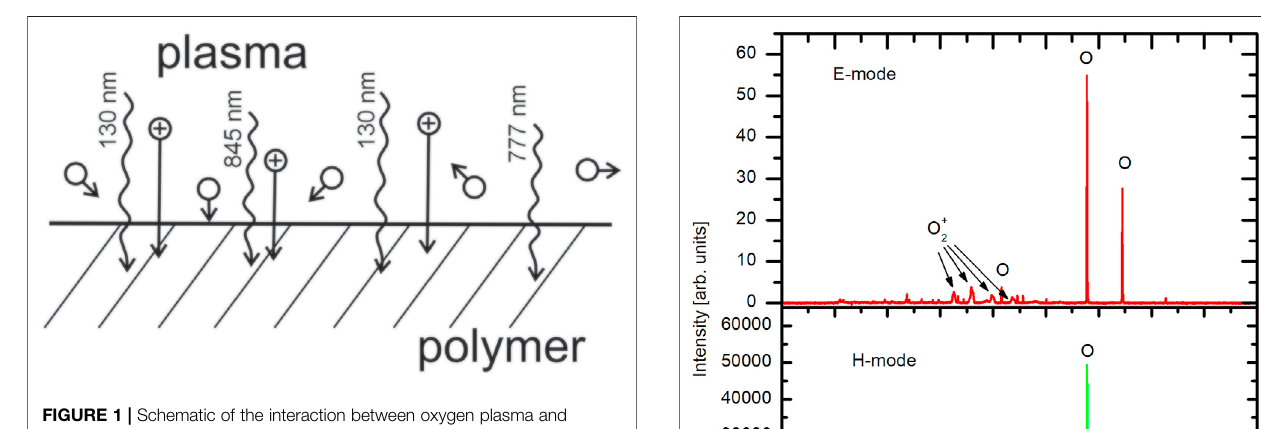
FIGURE 1 | Schematic of the interaction between oxygen plasma and polymers.